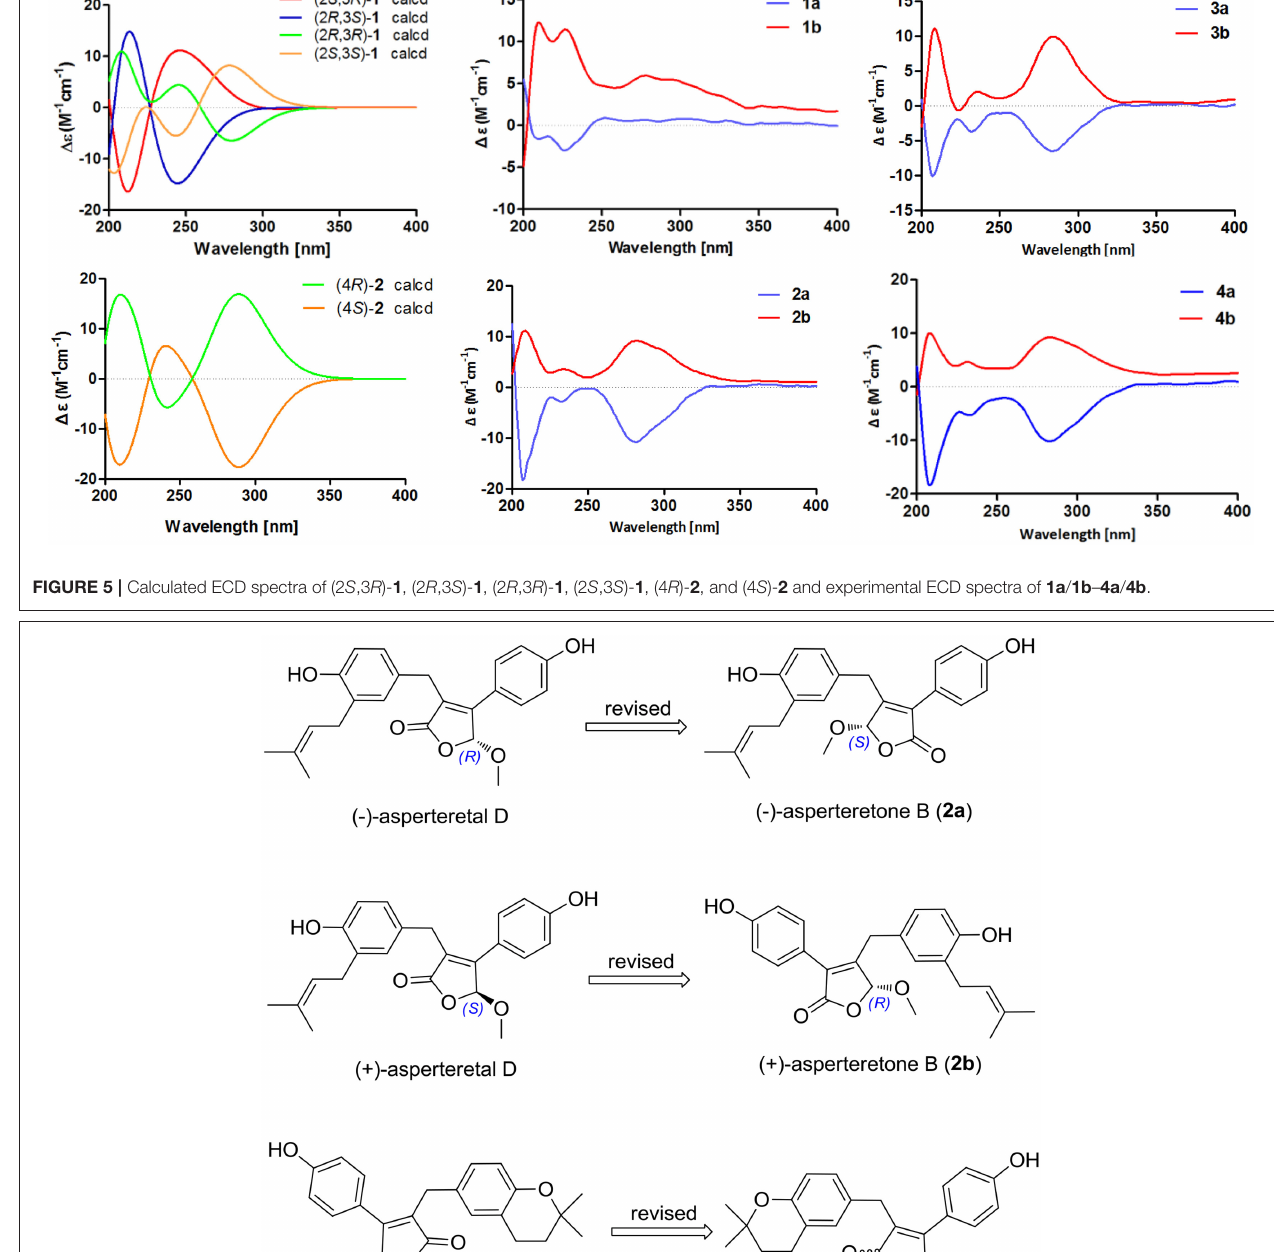
)-asperteretal D and (4 S )-4-decarboxylflavipesolide C to 2-phenyl-3-benzyl-type ( ±